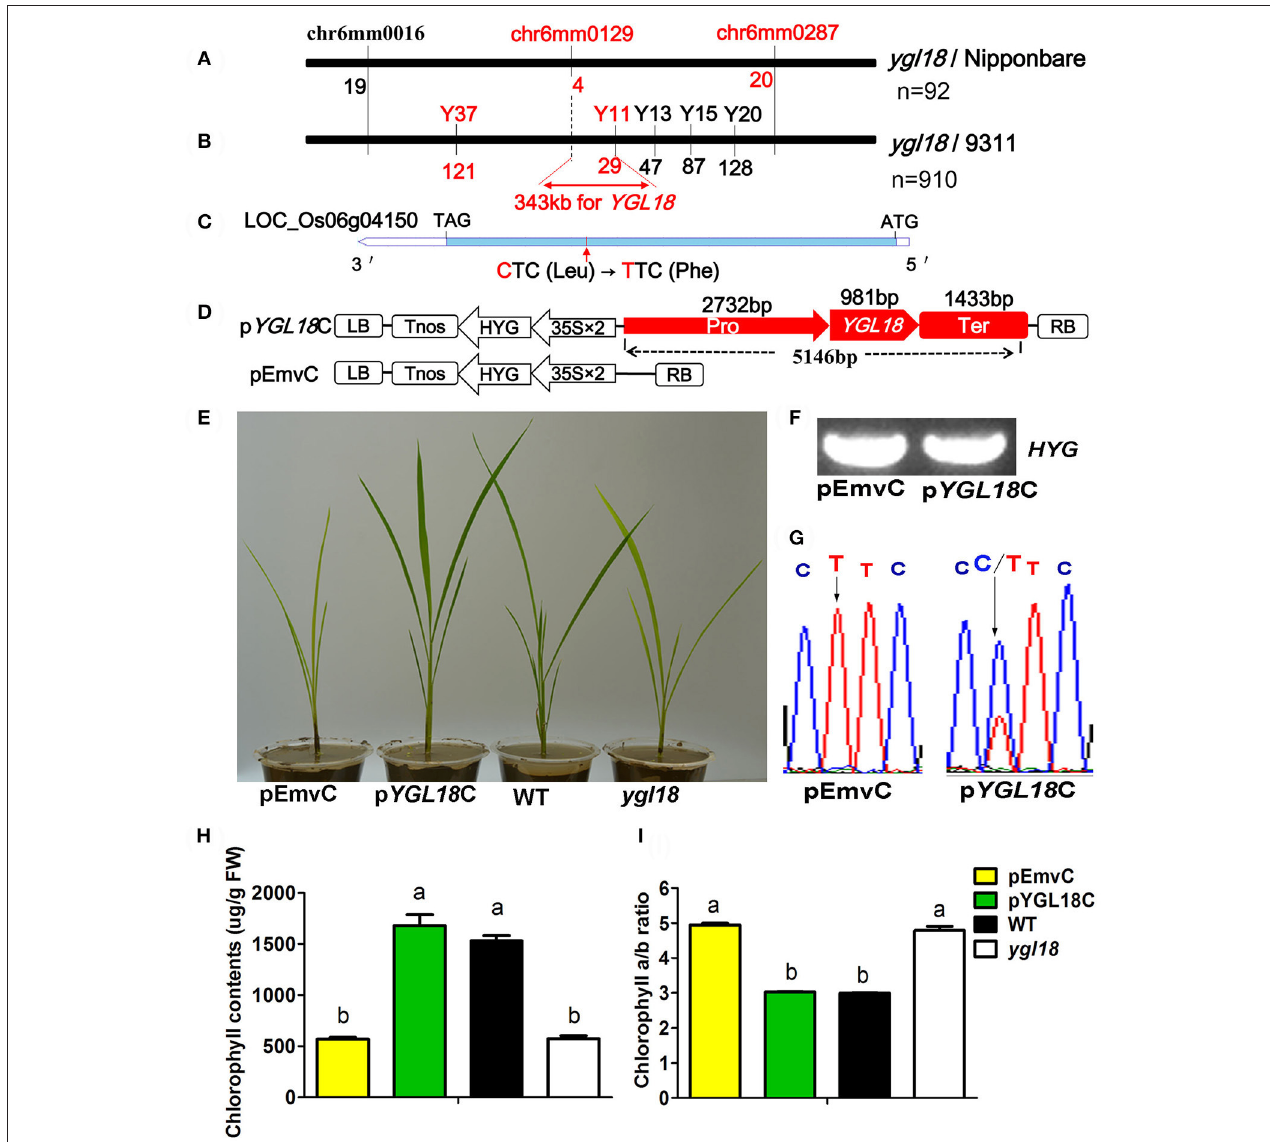
FIGURE 2 | Map-based cloning and functional complementation of YGL18 . (A) Preliminary mapping identified the YGL18 locus as occurring between chr6mm0129 and chr6mm0287 on the rice chromosome 6, by using 92 F 2 recessive individuals from the cross of ygl18 and “Nipponbare.” The number of recombinants is indicated below the marker. (B) The YGL18 locus was mapped to lie between markers Y37 and Y11 by 910 F 2 recessive individuals from the cross of ygl18 and “9311.” Accordingly, a candidate region of 343kb between chr6mm0129 and Y11 was summarized. (C) Gene structure of the YGL18 candidate, LOC_Os06g04150. The blue bar indicates the CDS region. The red arrow indicates the point mutation of C–T, leading to the amino acid exchange of Leu to Phe. (D) Vectors for the complementary experiment. The functional complementary vector p YGL18 C contains the promoter (Pro), gene region ( YGL18 ), and terminator (Ter) of LOC_Os06g04150; pEmvC is the empty vector control. LB, left border; Tnos, the nopaline synthase terminator; HYG, the hygromycin gene; 35S, cauliflower mosaic virus 35S promoter; RB, right border. (E) Transgenic plants of pEmvC and p YGL18 C grown in the green house. (F) Positive amplification of the transgenic marker element ( HYG gene) in the transgenic plants of pEmvC and p YGL18 C. (G) Sequence analysis of the C-to-T mutation site in T 0 transgenic plants of pEmvC and p YGL18 C. (H) Chlorophyll contents in the transgenic plant leaves of pEmvC and p YGL18 C. FW, fresh weight. (I) Chlorophyll a / b ratio in the transgenic plant leaves of pEmvC and p YGL18 C. In (H,I) Data represent the mean ± SD of three biological replicates (one-way ANOVA analysis). Different letters indicate values are statistically different based on a one-way ANOVA